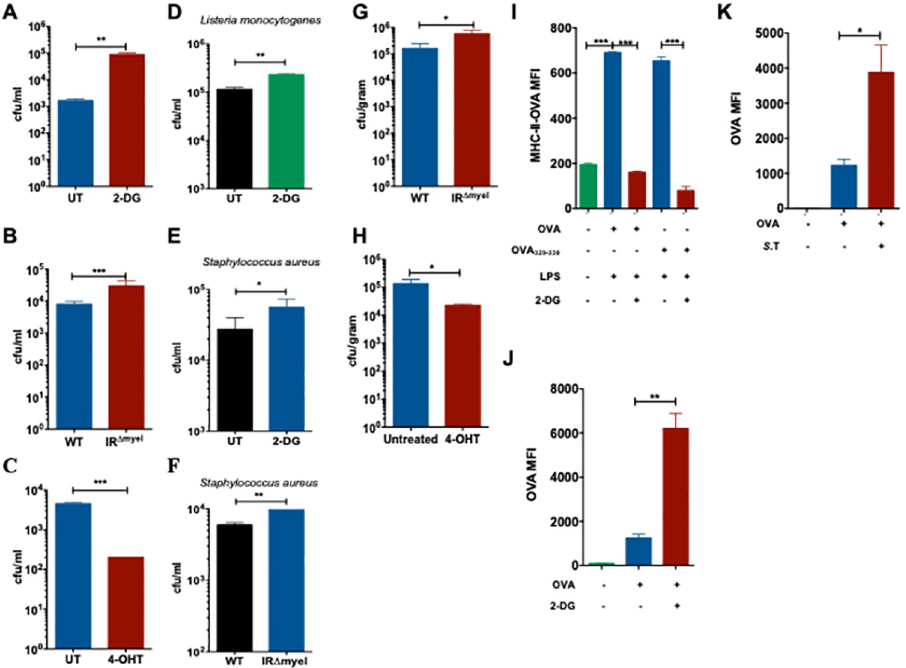
Fig 3. Macrophage depend on glycolysis for the clearance of intracellular bacteria. (A) Bacterial burden expressed as colony forming units (CFU) after 24h of S. Typhimurium infection in 2-DG-treated WT BMDMs compared to untreated (UT) controls (n = 5). (B) Intracellular S. Typhimurium load in WT and IR Δ myel BMDMs after 24h of infection (n = 3). (C) S. Typhimurium in 4-OHT-treated WT BMDMs compared to untreated (UT) controls after 24h of infection (n = 3). (D) L. monocytogenes (E) S. aureus burden in 2-DG-treated WT BMDMs compared to untreated (UT) controls (n = 3). (F) S. aureus burden in WT and IR Δ myel BMDMs (n = 3) 24h post-infection. (G) Bacterial load in livers of WT and IR Δ myel mice after 3 days post S . Typhimurium infection or (H) 4-OHT-treated mice. Data represent 2 experiments with 5 mice each. Data are shown as mean ± S.E.M. and statistical significance calculated using student t-test and represented as � = p < 0.05; �� = p < 0.01; ��� = p < 0.001. (I) MFI of OVA323-339-MHC II complexes on the surface of WT BMDMs pre-treated with 2-DG and LPS (n = 3). (J) MFI of unprocessed Alexa647-labelled OVA in phagosomes isolated from 2-DG-treated BMDMs analyzed by flow cytometry (n = 3). All samples were pre-stimulated with LPS. (K) MFI of unprocessed Alexa647-labelled OVA in bead containing phagosomes isolated from S. Typhimurium-infected BMDMs analyzed by flow cytometry (n = 3).